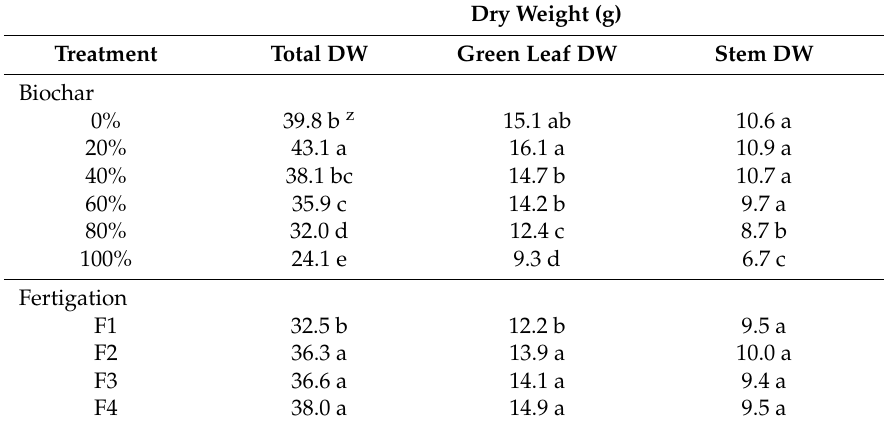
Table 3. Total dry weight (Total DW = green leaf DW + red bract DW + stem DW), green leaf and stem biochar and fertigated at four different regimes. All data were collected at 15 weeks after